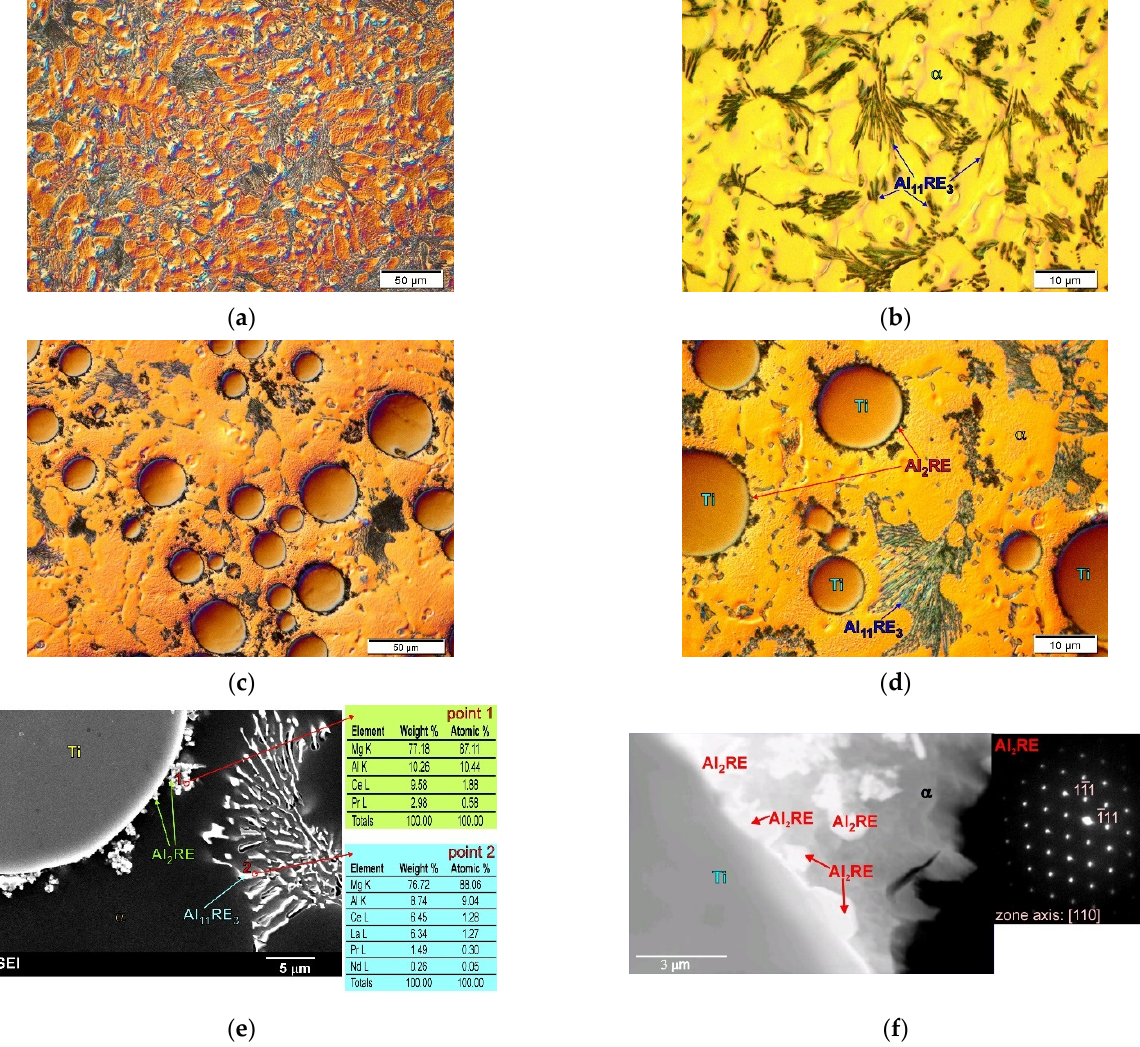
Figure 5. Microstructure of AME505 magnesium alloy. ( a , b ) Micrographs taken at different magnification and microstructure of AME505 matrix composites with SiC particles. ( c , d ) Micrographs taken at different magnification; ( e ) SEM micrograph of composite microstructure with EDX results from designated points; ( f ) TEM micrograph of interface between components with diffraction pattern from observed Al 2 RE phase.